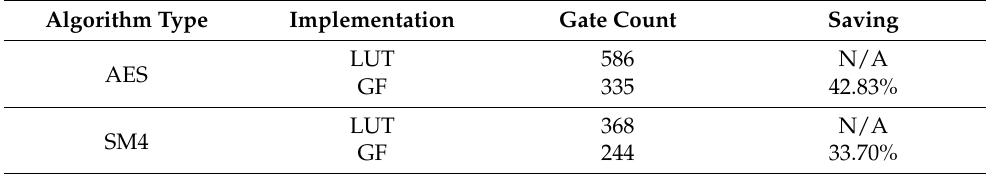
Table 5. Hardware overhead of S-Boxes based on LUT and GF(((2 2 ) 2 ) 2 ) in 65-nm ASIC implementation.